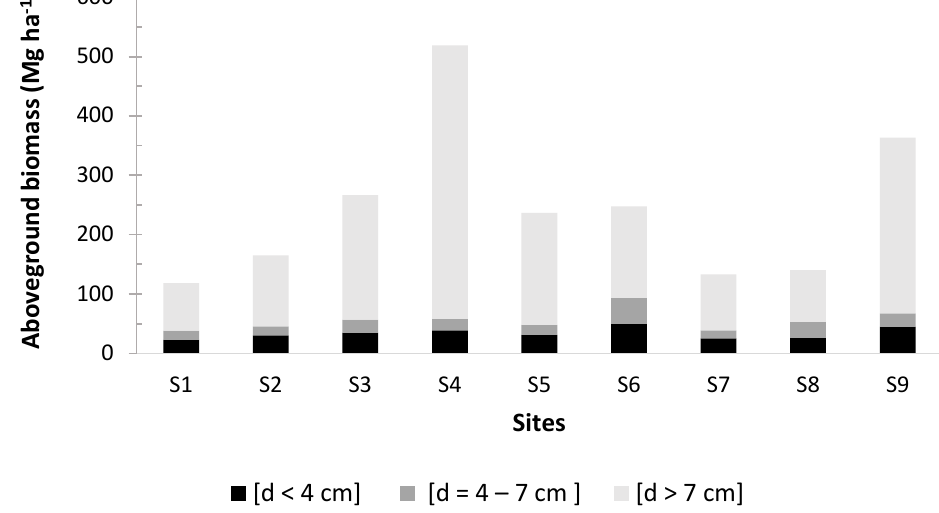
Figure 3. Estimates of standing biomass on the nine sites before harvest by diameter classes.